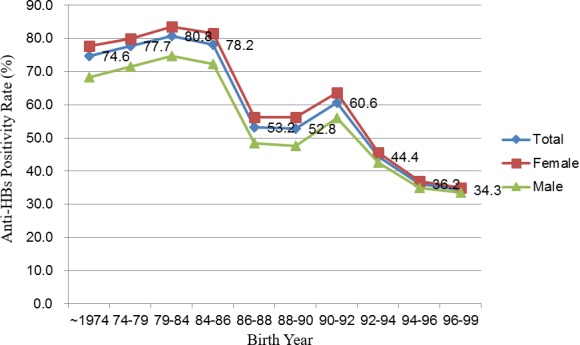
Antibody against hepatitis B surface antigen positivity status of the students from a university in Taiwan who were enrolled between 2005 and 2016 according to birth year.